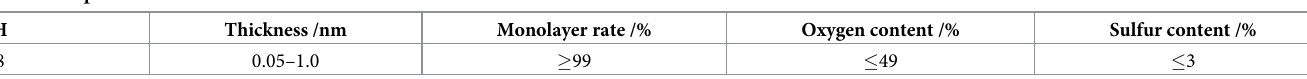
Table 2. Dispersion technical index of GO.